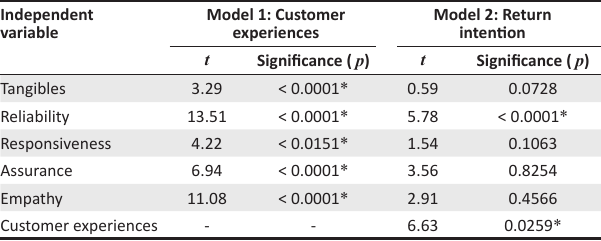
TABLE 4: Regression results of customer experiences and return